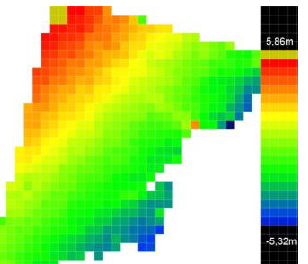
Figure 9. Tilt of DSM based on 2D orientations with bias correction by affinity transformation